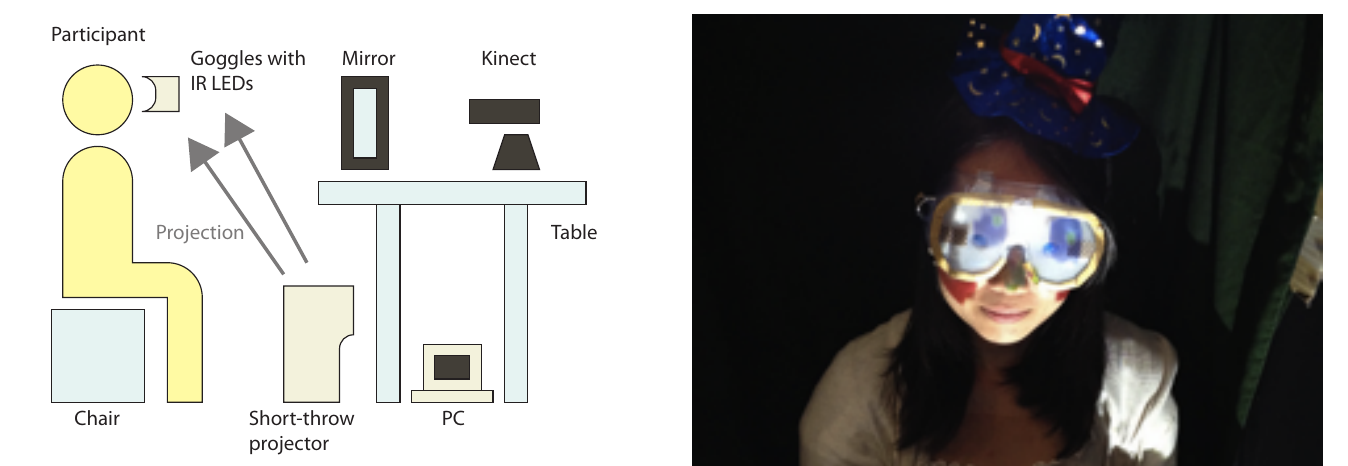
Fig. 2. Side view of the first prototype.